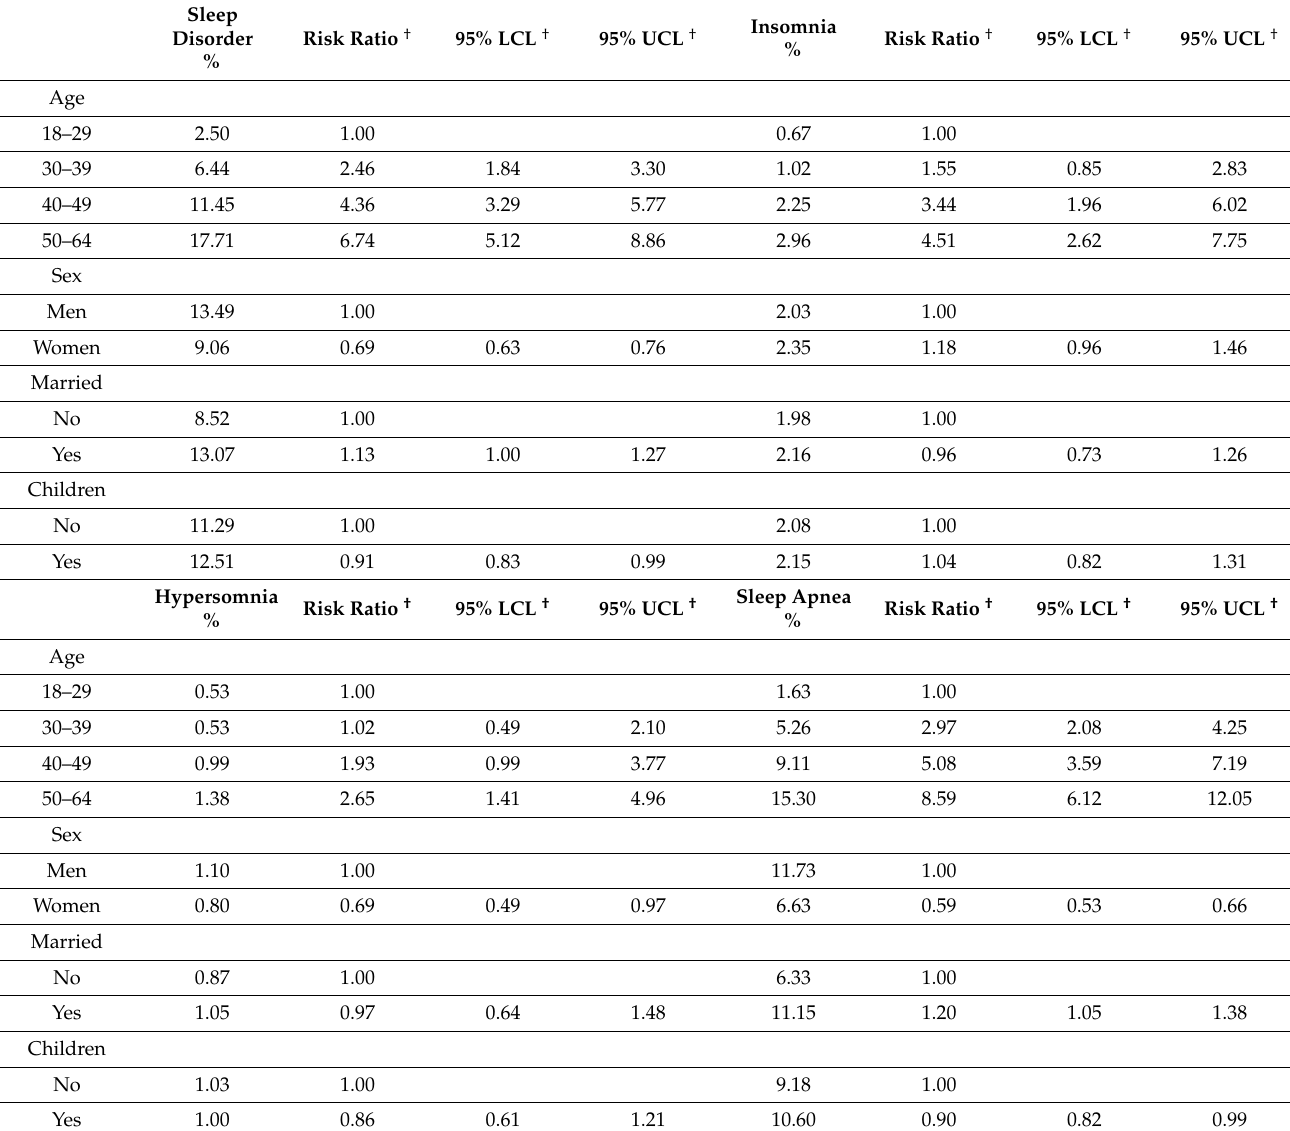
Table 2. Risk of Sleep Disorders in Employees According to Selected Demographic Variables,